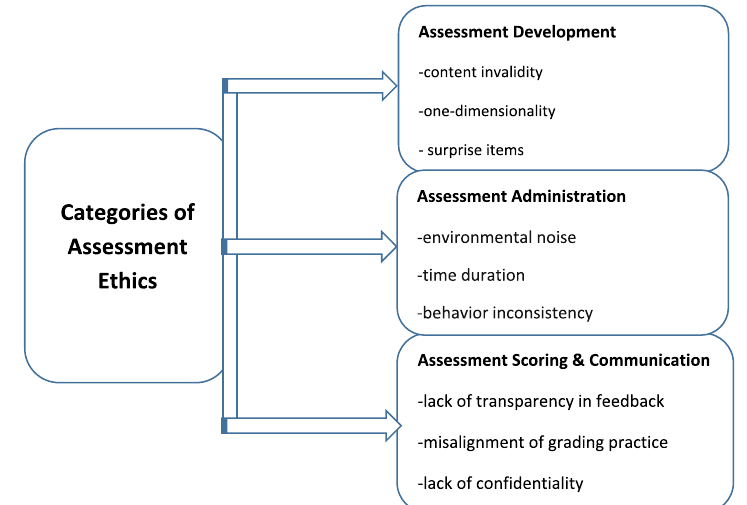
Fig. 1 Categories of assessment